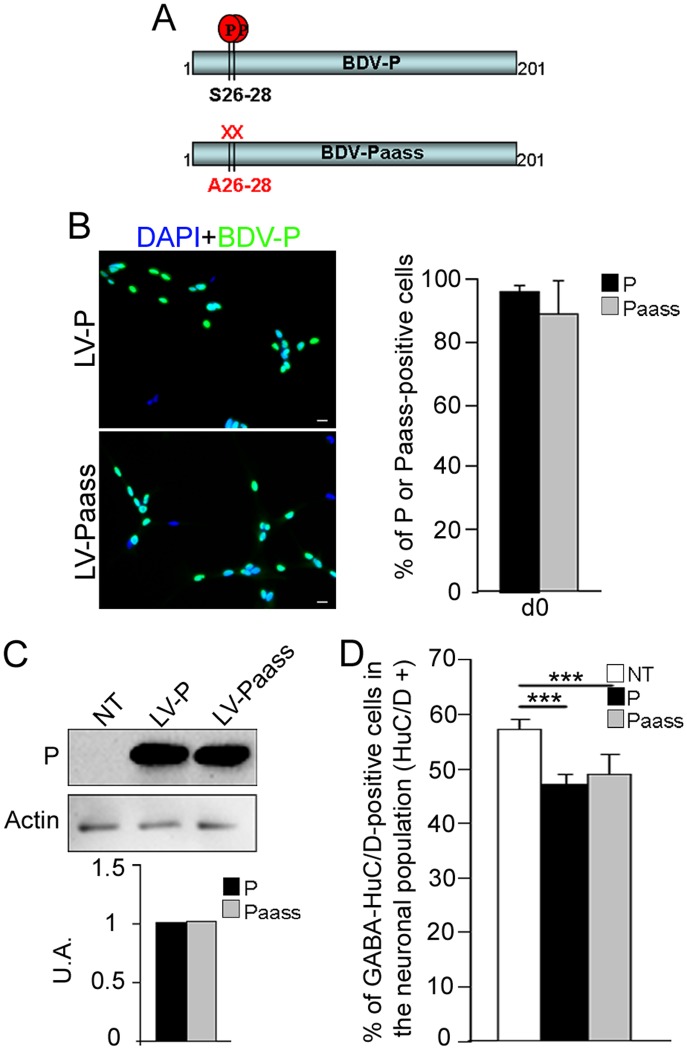
The S26/28 phosphorylation site is not necessary for bdv-p-induced reduction in GABAergic neurogenesis.(A) Schematic representation of P and Paass. Paass is mutated in S26/28 residues and thus lacks the corresponding phosphorylation site. (B) hNPCs were transduced with lentiviral vectors bearing the bdv-p or bdv-p
aass gene and immunostained at the undifferentiated stage (day 0) with an antibody directed against the P protein (green). Nuclei were stained with DAPI (blue). Transduction efficiency was evaluated by enumeration of P-positive cells (right panel). (C) Western blot showing the level of P in bdv-p and bdv-p
aass-expressing hNPCs at 14 days of differentiation. P is normalized to actin. (D) Transgenic hNPCs and their NT matched controls were induced to differentiate for 14 days and GABAergic neurons were quantified. The results are representative of 2 independent experiments performed in triplicate. Statistical analyses were performed using the Mann-Whitney test. ***, p = 0.002. Scale bar, 20 μm.